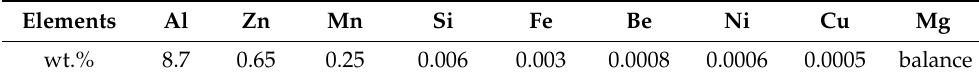
Table 1. Chemical composition of AZ91 magnesium alloy (in